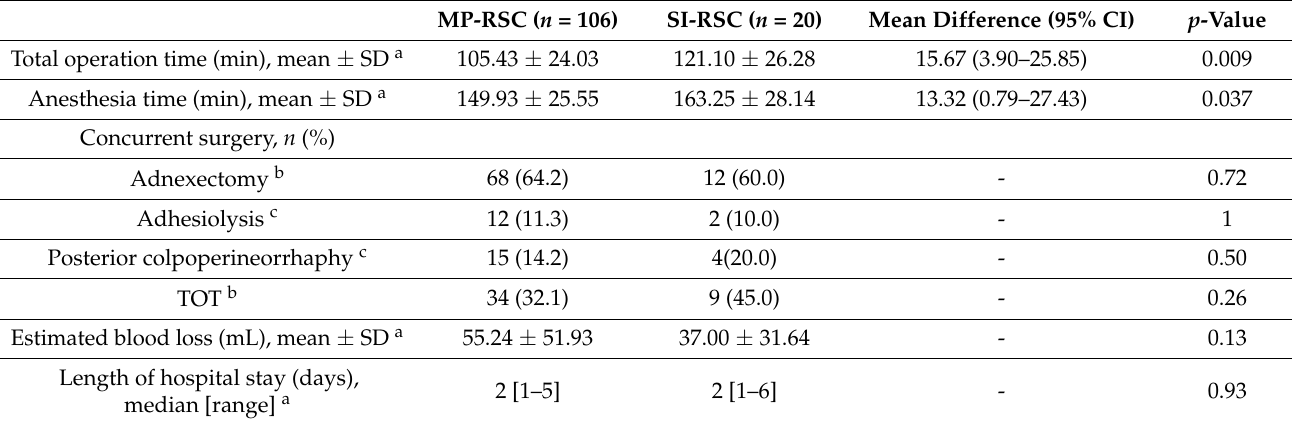
Table 2. Surgical and perioperative data.